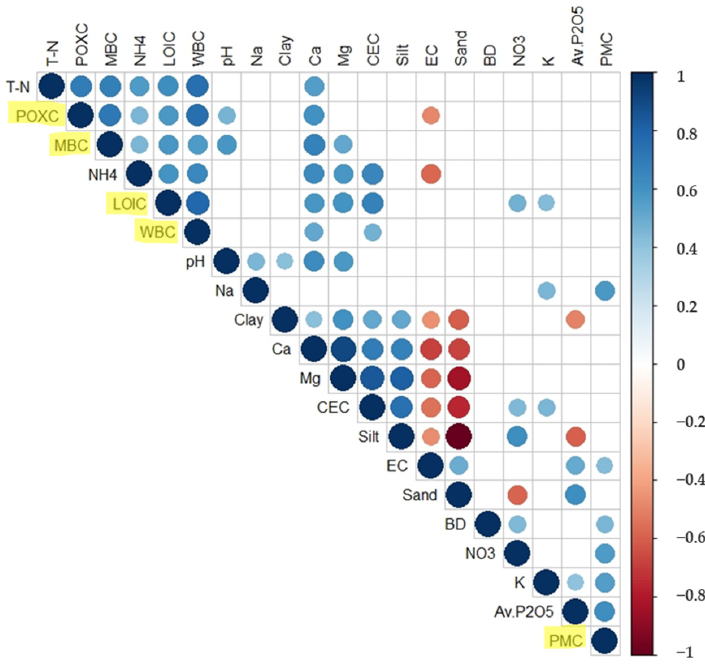
Figure 2. Correlation matrix among soil organic C fractions (LOIC, WBC, POXC, PMC, and MBC; highlighted in yellow) and soil biogeochemical parameters (bulk density; pH; EC; T ‐ N; ammonium; nitrate; CEC; soluble P, Ca, K, and Mg; and particles including clay, silt, and sand). The areas of circles show the value of corresponding Pearson correlation coefficients with significance at the 0.05 probability level. Correlation values are displayed by circle in the upper panel; positive correlations are shown in blue and negative correlations in red. Color intensity (light to dark) and the size of the circle (small to big) are proportional to the correlation coefficients (0 to 1 for positive and 0 to − 1 for negative), where, for example, the correlation coefficients on the principal diagonal are equal to 1, represented in dark blue and largest size of circle. The legend on the right side of the correlogram shows the Pearson correlation coefficients with their corresponding colors.